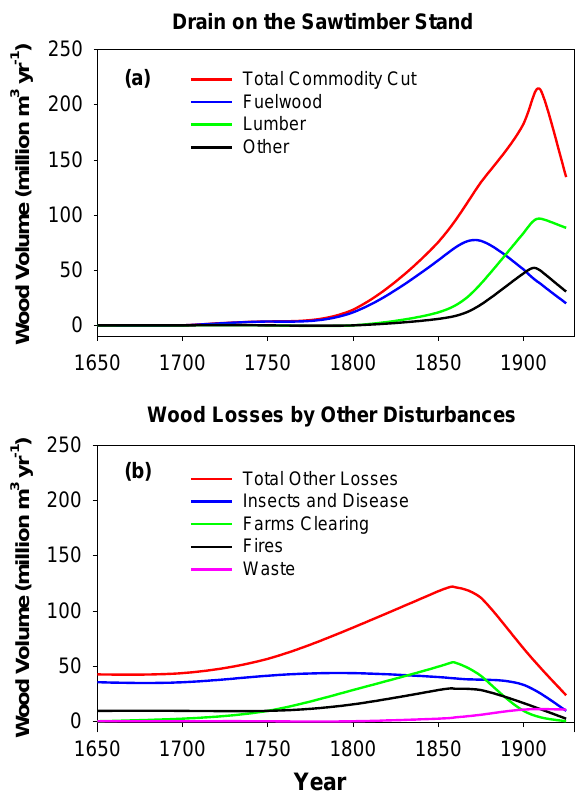
Fig. 2. Impacts of disturbances on forests in the past: (a) Drain on Figure 2. Impacts of disturbances on forests in the past: (a) Drain on the U.S. Sawtimber Stand, 1650-1925 (unit: million cubic meters per year based on sawtimber volume); and (b) wood losses the US Sawtimber Stand, 1650–1925 (unit: million cubic meters affected by other disturbances (based on the data from Birdsey et al., 2006). per year based on sawtimber volume); and (b) wood losses affected by other disturbances (based on the data from Birdsey et al.,